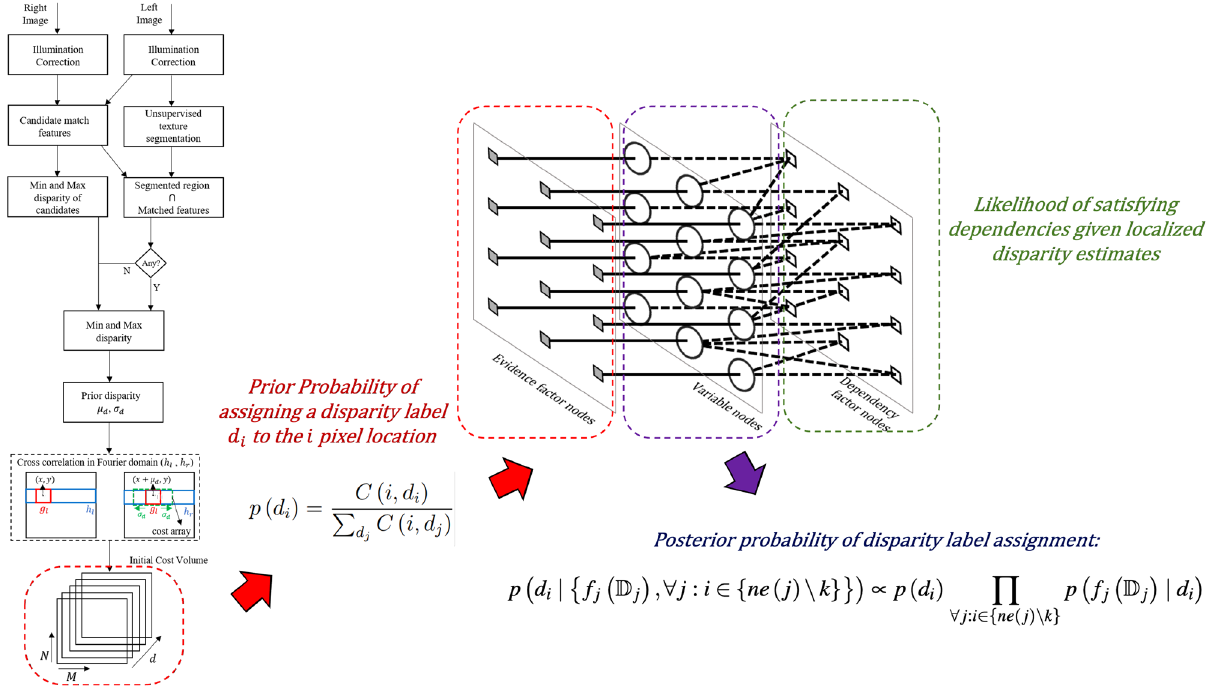
Figure 1. Overview of the FGS algorithm illustrating generation of a priori distribution from a stereo pair and calculating a posterior disparity distribution using our factor graph design. A detailed illustration of our factor graph architecture is shown in Fig. 2 and the sparse cost volume calculations used for building a priori disparity distributions are shown in Fig.